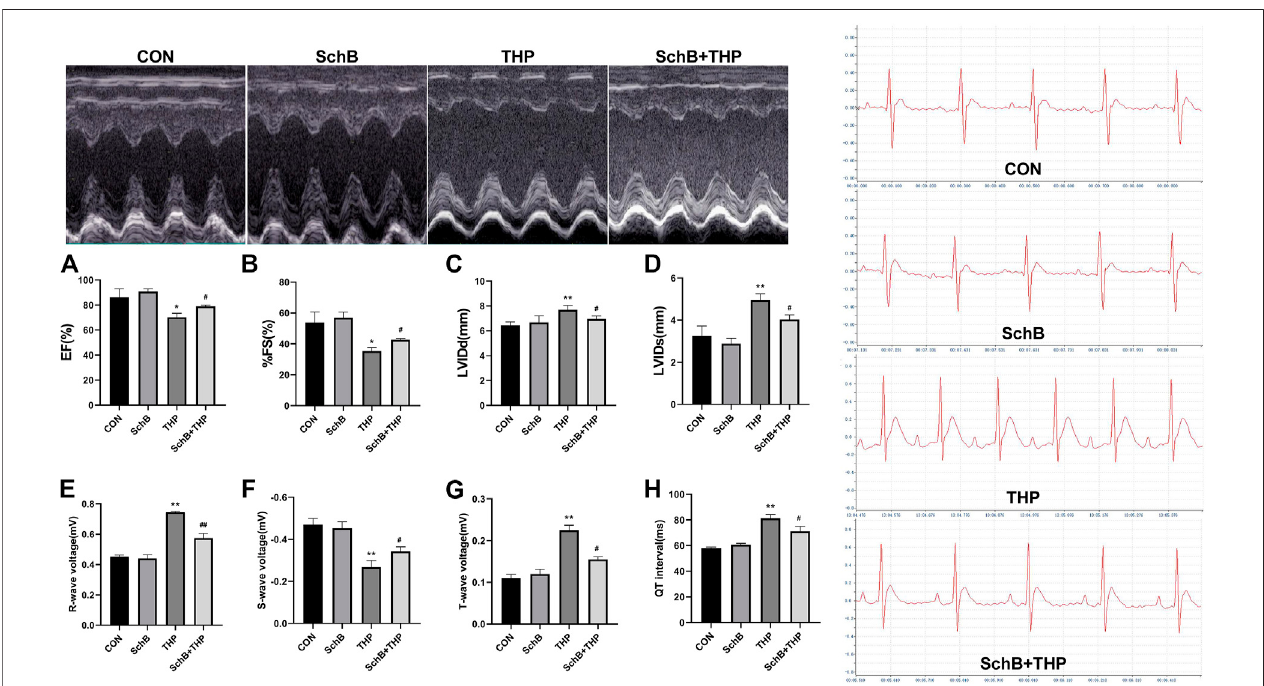
FIGURE 2 | SchB effectively improved the echocardiographic and ECG changes of SD rats induced by THP. Compared with normal rats, EF (A) and % FS (B) decreased and LVIDd (C) and LVIDs (D) thickened (THP vs. CON). Compared withnormalSDrats, the ECG ofTHP ratswas alsoabnormal (THPvsCON). The R wave (E) andTwave (G) voltageincreased;Swavevoltagedecreased (F) ;andQTinterval (H) prolonged(THPvs.CON).AftertreatmentwithSchB(50 mg*kg − 1 ),theabovechanges were signi fi cantly improved (SchB + THP vs. THP). All values are mean ± SD. *p < 0.05 vs. CON , ** p < 0.01 vs. CON , # p < 0.05 vs. THP , and ## p < 0.01 vs. THP